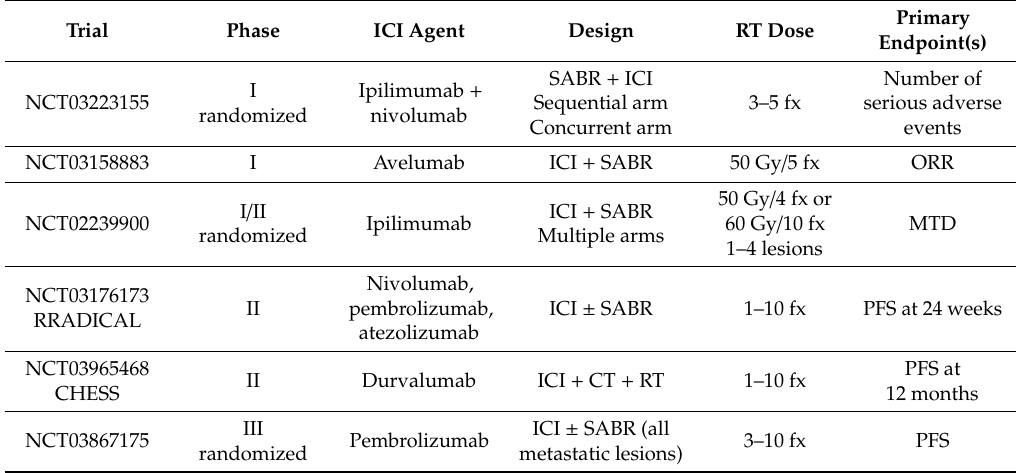
Table 3. Ongoing clinical trials in patients with metastatic NSCLC receiving ICI and